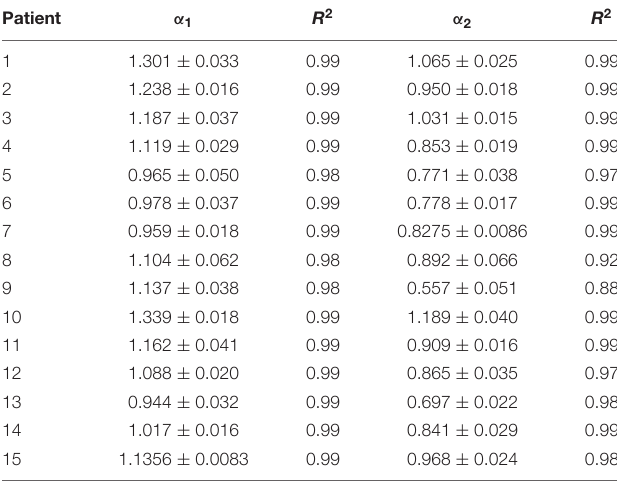
TABLE 2 | Estimated values of short-term ( α 1 ) and long-term ( α 2 ) scaling exponents in the first cluster of heart failure patients. Patient